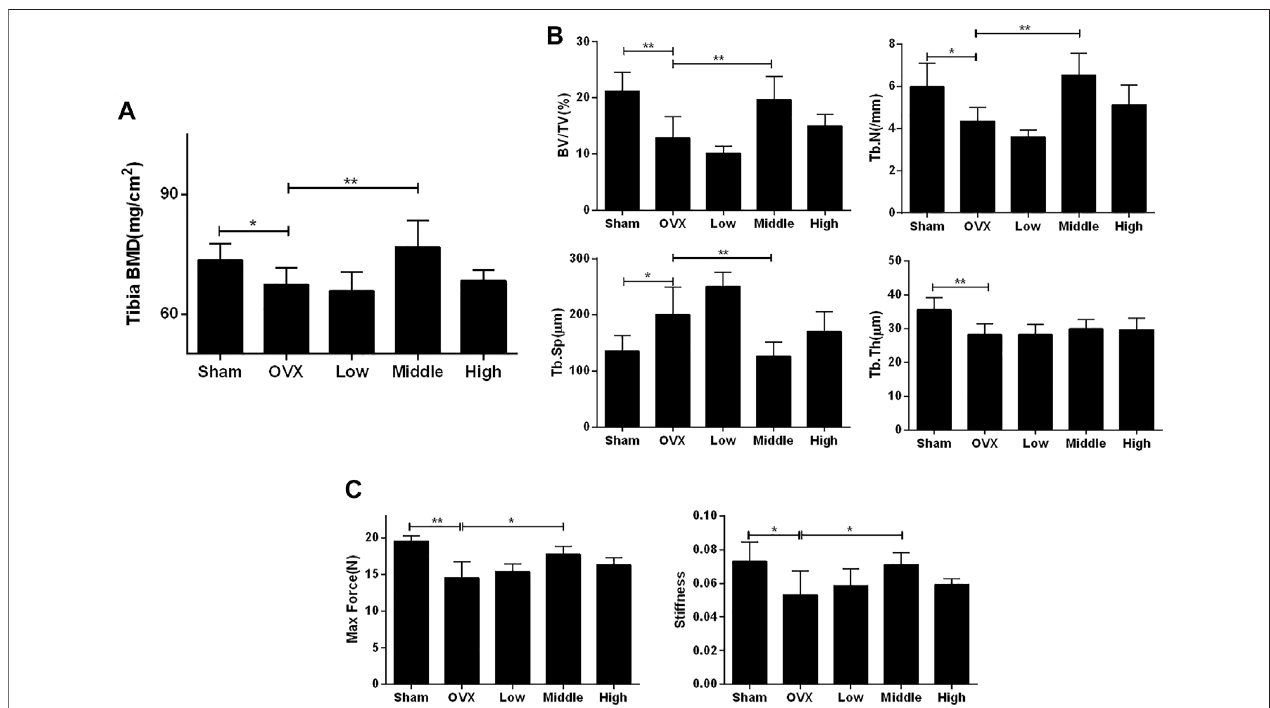
FIGURE3| NitazoxanidepreventedOVX-inducedbonelossandbonestiffnessdecrease. (A) TheleftwholetibiaBMDweremeasured. n (cid:2) 10 – 13. (B) Thetibiasof mice were scanned by high-resolution micro-CT. Calculation of the microarchitectural parameters was performed. n (cid:2) 6. (C) The maximum load and stiffness were determined in a three-point bending test. n (cid:2) 6. Data are shown as mean ± SD. BMD, bone mineral density; BV/TV, bone volume/tissue volume; Tb.N, trabecular number; Tb.Sp, trabecular separation; Tb.Th, trabecular thickness. * p value ＜ 0.05, ** p value ＜ 0.01.